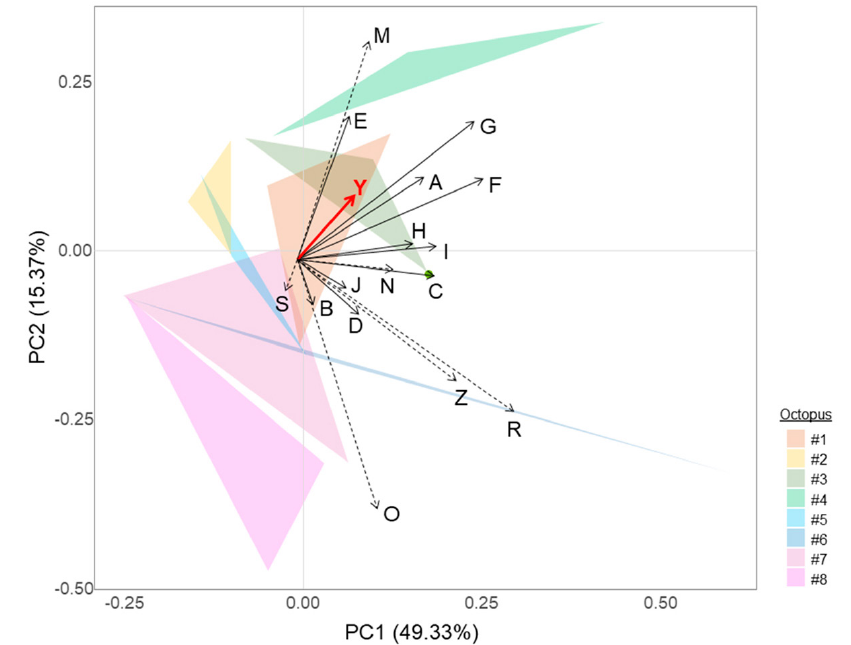
Fig. 4. – Scatterplot of two main principal components for O. vulgaris individuals regarding observed behaviour (continuous black vectors) and body patterns (dotted vectors) during the experimental tests. The red vector shows capturing the bait (Y). The coloured triangles were built according to the results of the three tests performed on each individual. A, arm exploration; B, body exploration; C, crawl; D, defence position; E, pulling the trap; F, approaching the trap; G, grabbing the trap; H, retreat; I, resting in the den; J, jet swim; Y, capture bait/prey; M, broad mottle skin; N, hood/striped skin pattern; O, passing cloud skin pattern; R, regular skin pattern; S, smooth texture; Z, dark skin